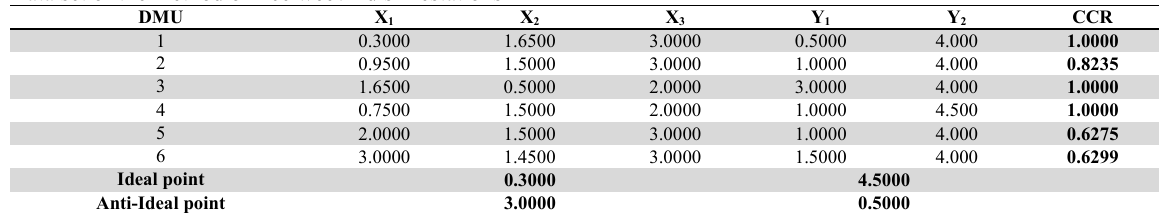
Data set of the method of rice weevil disinfestations